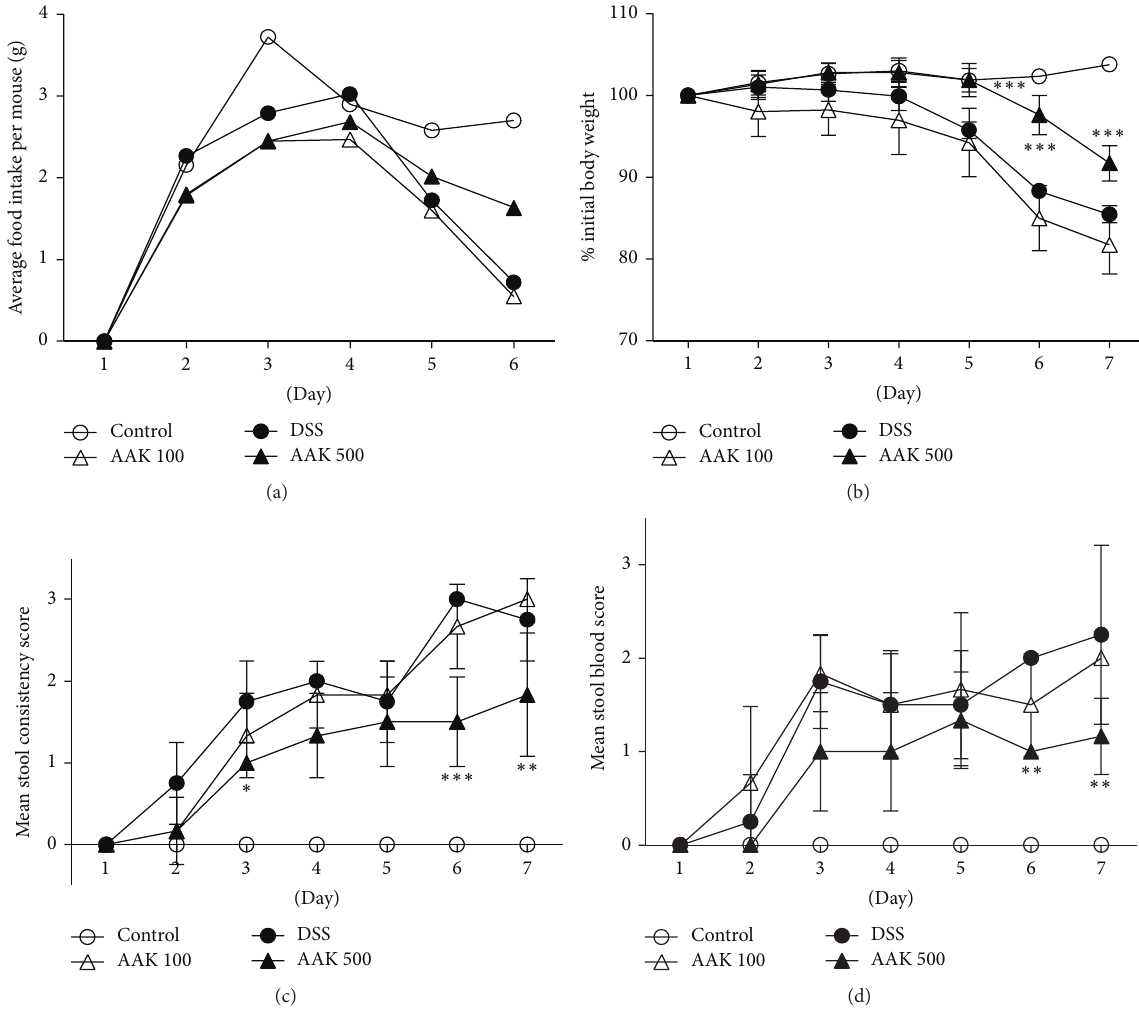
Figure 2: Effects of AAK extract on the symptoms of DSS-induced colitis. (a) Daily changes of food intake. Average food intake per mouse was calculated by dividing total consumption of chow on a specific day with the number of mice per cage. (b) Daily changes of body weight. Body weight was calculated by dividing weight on a specific day with the initial weight of each mouse. Stool samples were monitored daily for scoring of (c) consistency and (d) occult blood. Data represent the percentage or mean ± SD ( 𝑛 = 4 – 6 per group). ∗ 𝑝 < 0.05 ; ∗∗ 𝑝 < 0.01 ; ∗∗∗ 𝑝 < 0.001 versus